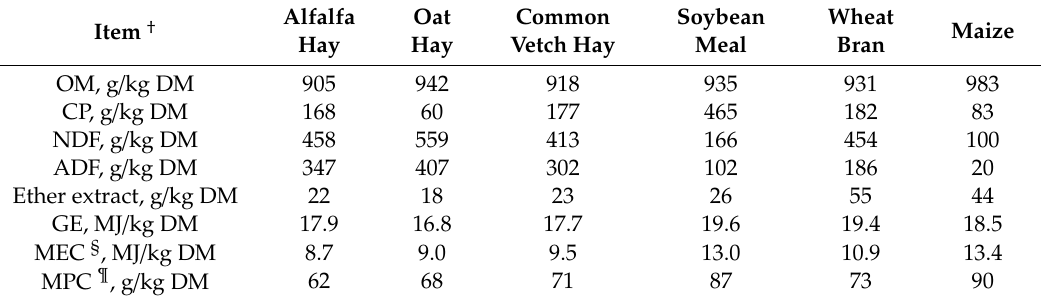
Table 1. Chemical composition of alfalfa hay, oat hay, common vetch hay, and ingredients of the concentrate used in the experimental